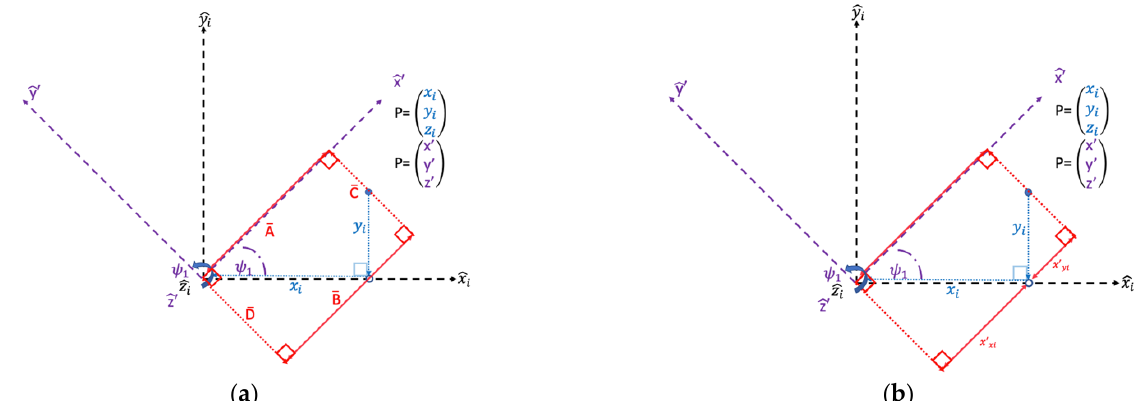
Figure 9. ( a ) 3-rotation about the ˆ z i and ˆ z (cid:48) axes adding parallel lines C and D to create rectangle ABCD . ( b ) 3-rotation about the ˆ z i and ˆ z (cid:48) axes and dividing B into measurable sections x (cid:48) xi and x (cid:48) yi .